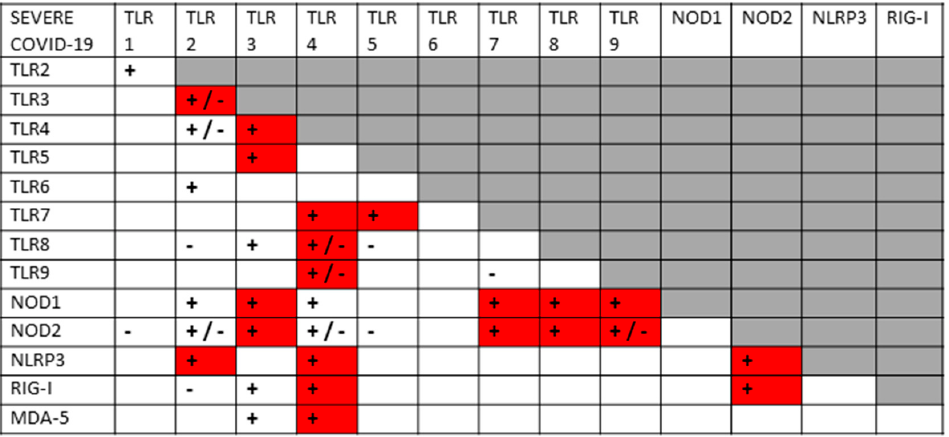
Figure 5. Predicted synergisms (+) and antagonisms ( − ) resulting from severe COVID-19 activation of innate receptors resulting from mapping Figure 3 (literature review of innate receptor activation) onto the template provided by Figure 2 (summary of known innate receptor synergisms and antagonisms). Red entries indicate extracellular (“bacterial antigen”) receptor synergisms with intracellular and endosomal (“viral antigen”) receptors.